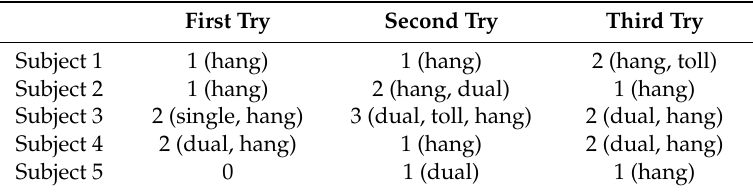
Table 5. Results of the third walking test (failure of obstacle avoidance).